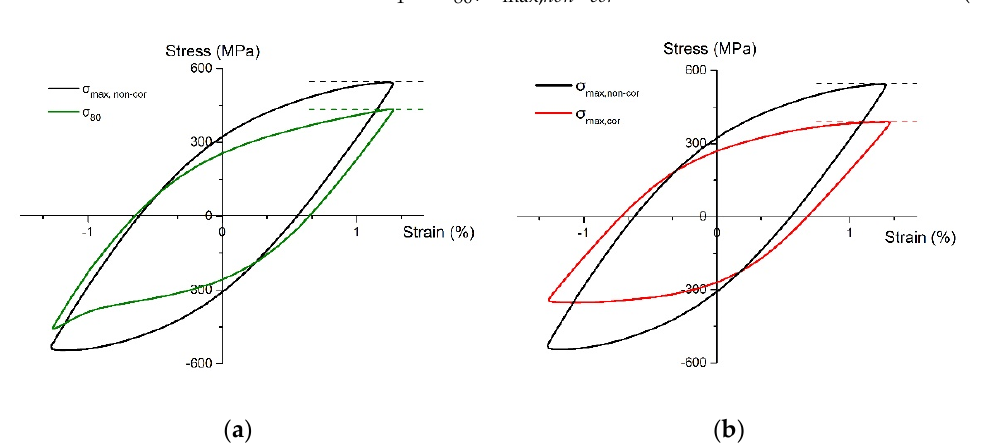
Figure 9. Definition of ( a ) maximum stress σ max, non-cor and maximum stress at the lower limit of 80% of the maximum loads σ 80 of the non-corroded steel bar and ( b ) maximum stress σ max,cor of the corroded steel bar.